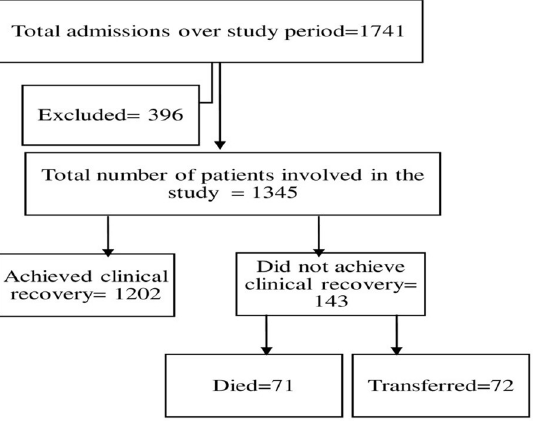
Fig 1. Flow chart showing the disposition of study participants in the final